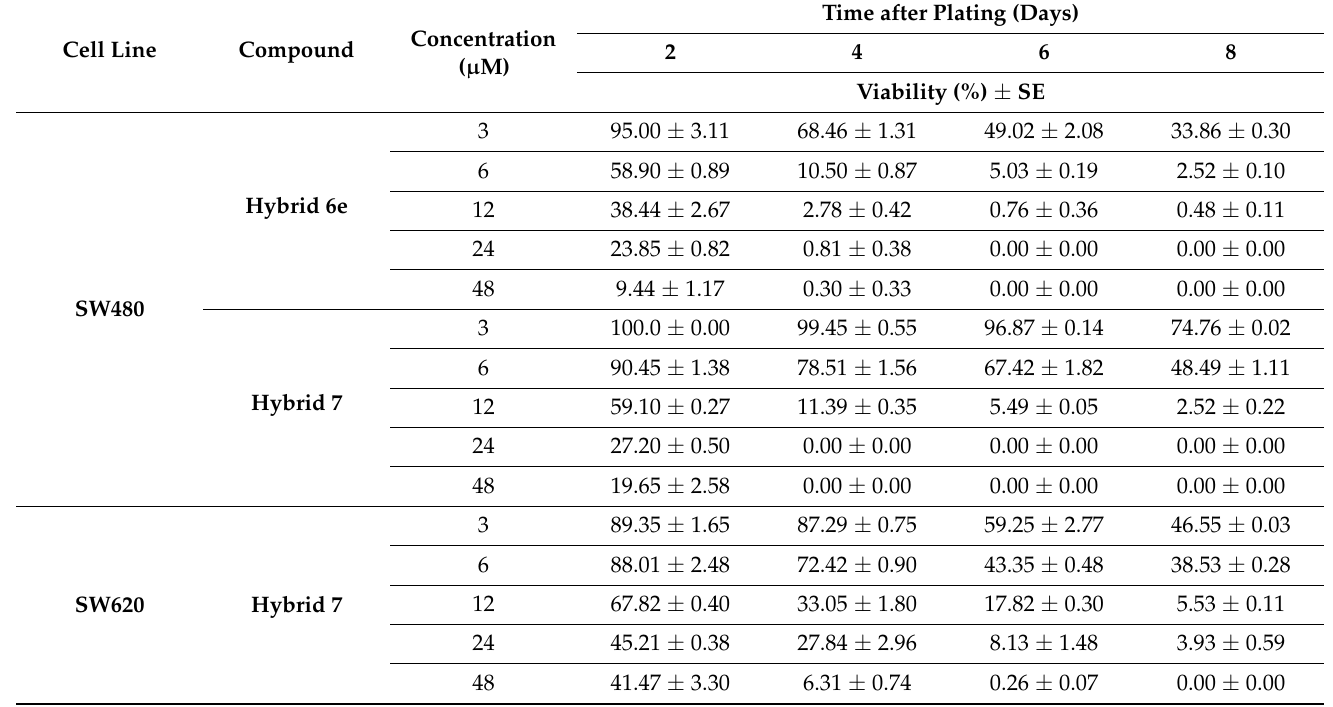
Table 2. Data of viability (%) different concentrations